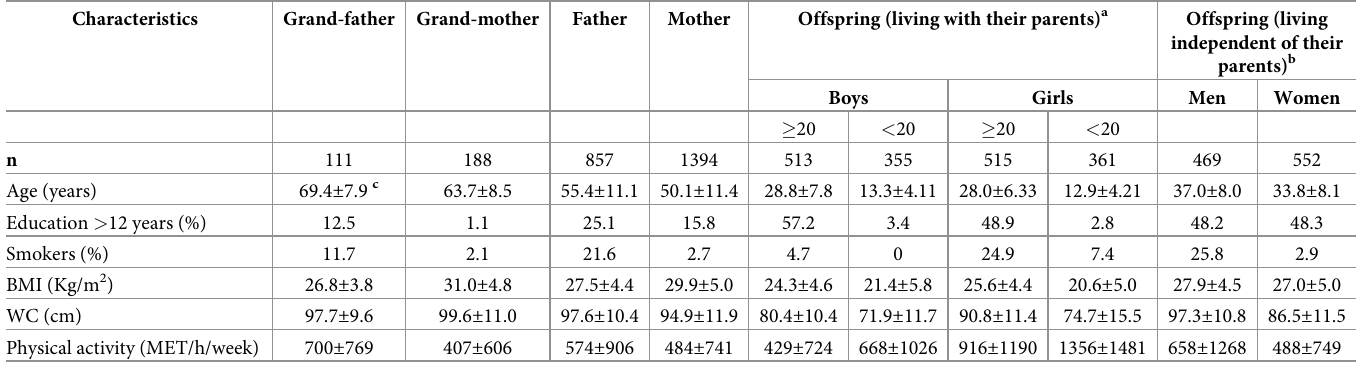
Table 1. Characteristics of 3 generations of study participants: Tehran lipid and glucose study.